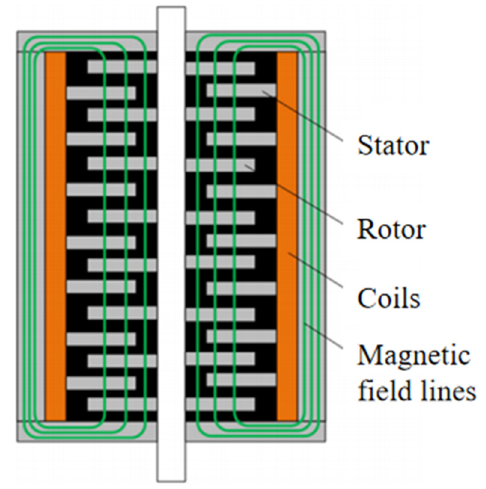
Figure 19. Large-scale MRD